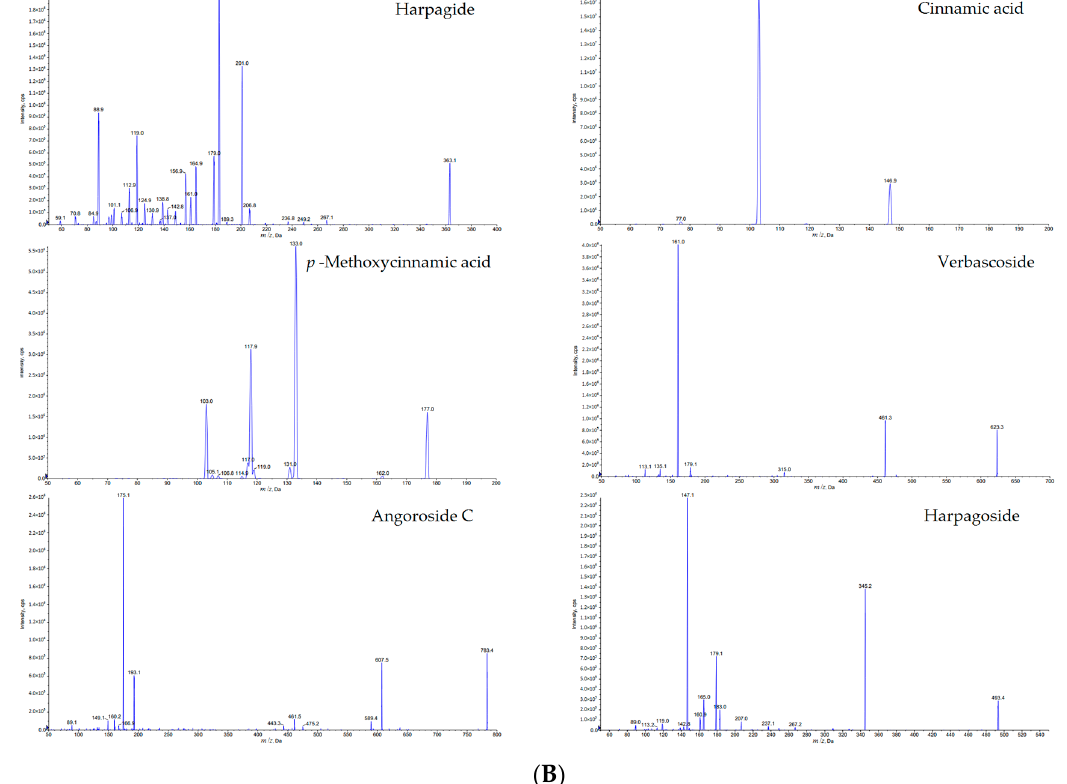
Figure 2 . Chemical structures of the twelve compounds analyzed in the study ( A ); and mass spectrums of the twelve compounds in negative mode ( B ).